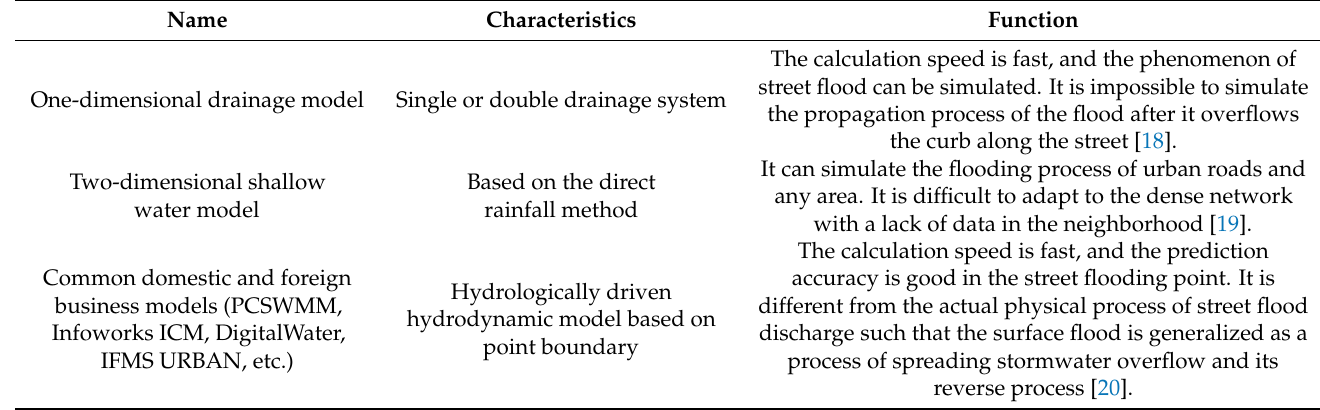
Table 1. Common urban waterlogging